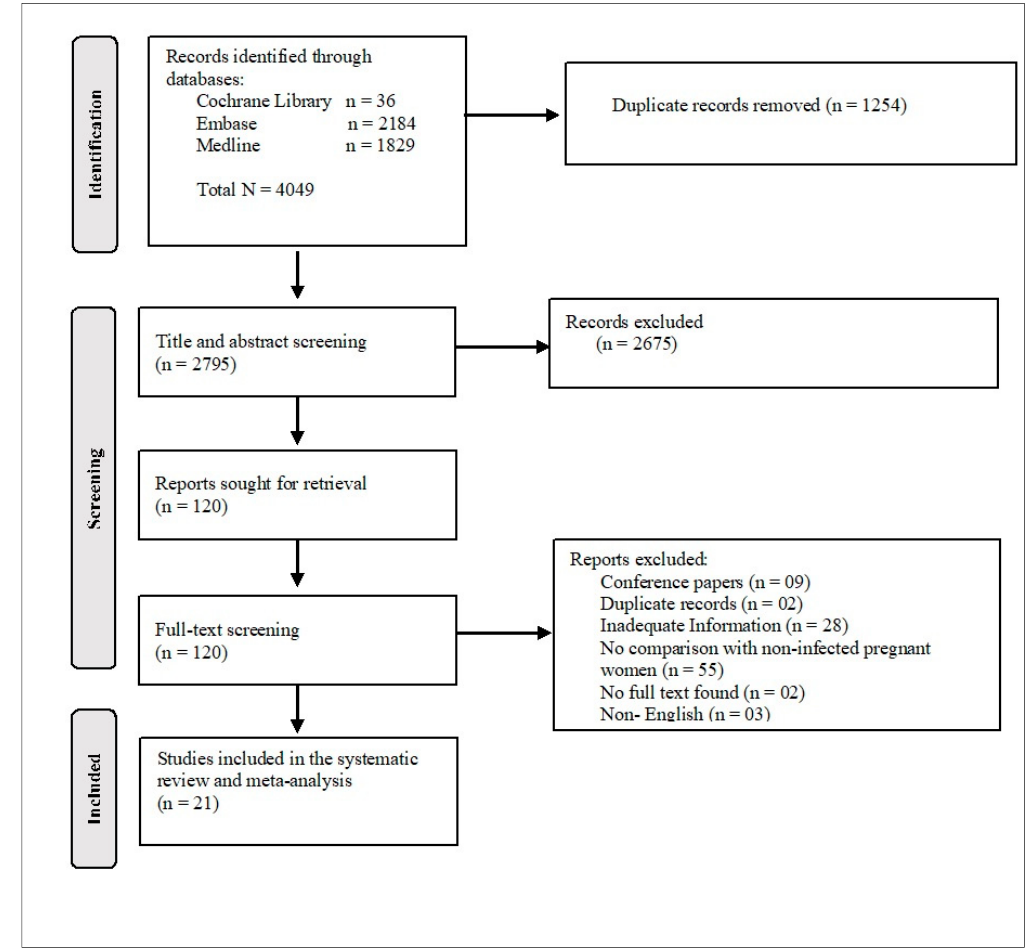
Figure 1. PRISMA flow chart of included studies. Table 1. Characteristics of included